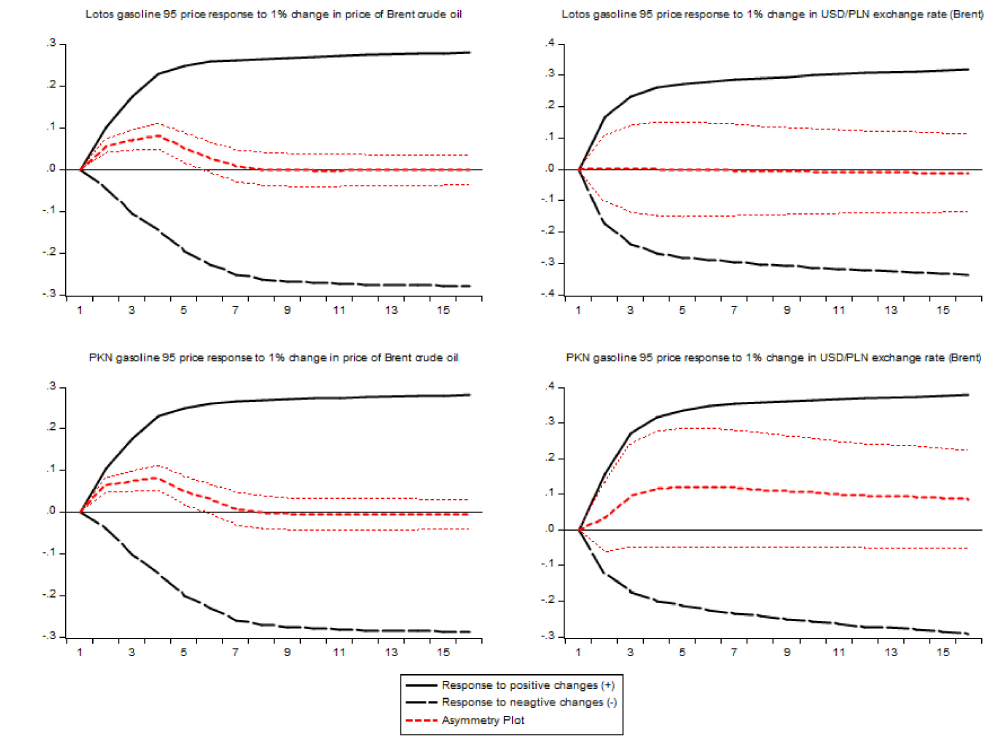
Figure 5. Dynamic multipliers—whole sample, wholesale Gasoline 95, and Brent crude.